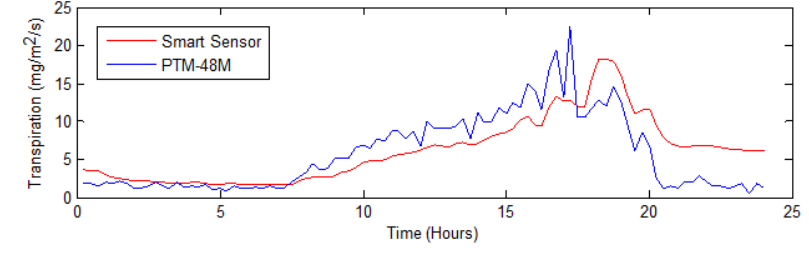
Figure 9. Comparison between the developed smart sensor and the PTM-48M transpiration